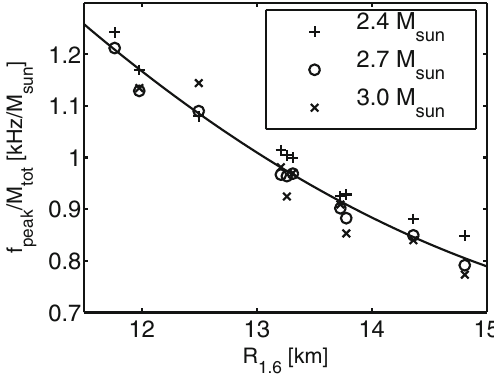
Fig. 35 Peak frequency f peak scaled by the total mass M tot versus the radius of a nonrotating NS of mass 1 . 6 M (cid:3) for different EOSs. The symbols correspond to different values of the total mass. The solid line shows the quadratic fit in Eq. (143), which can be used to determine R 1 . 6 with a maximum uncertainty of a few percent for a given f peak measurement in a system where the total mass M tot is determined from the inspiral gravitational waveform. (Image reproduced with permission from Bauswein et al. 2016, copyright by SIF/Springer)